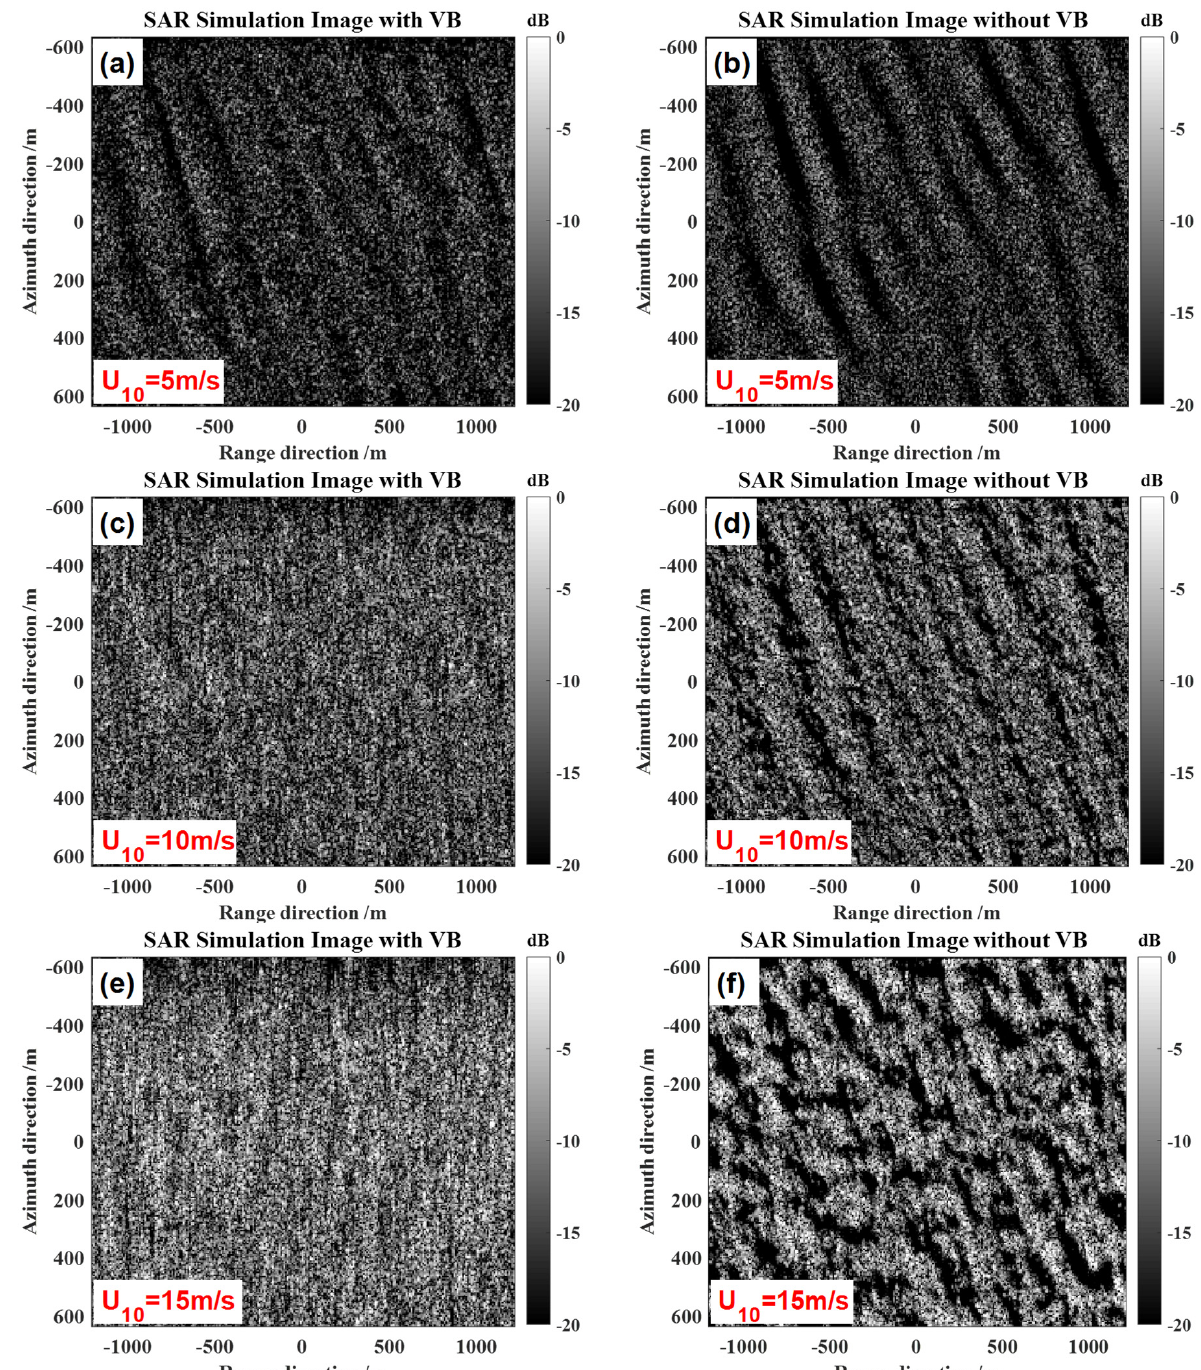
Figure 8. The SAR simulation images with the VB effect at different wind speeds: ( a ) U 10 = 5m/s, ( c ) U 10 = 10m/s, and ( e ) U 10 = 15m/s; without the VB effect at different wind speeds: ( b ) U 10 = 5m/s, ( d ) U 10 = 10m/s, and ( f ) U 10 =